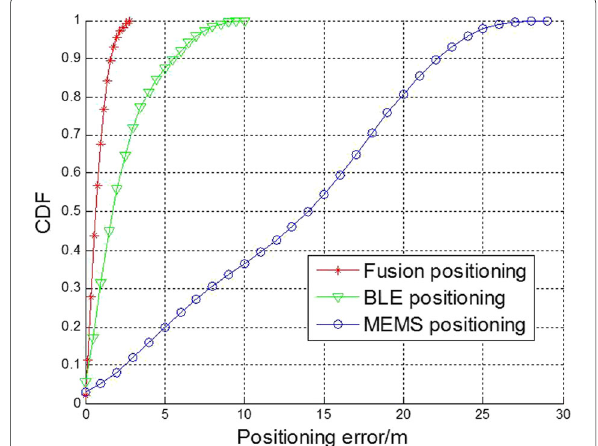
Fig. 31 Locations tracking under squareshape of trajectory